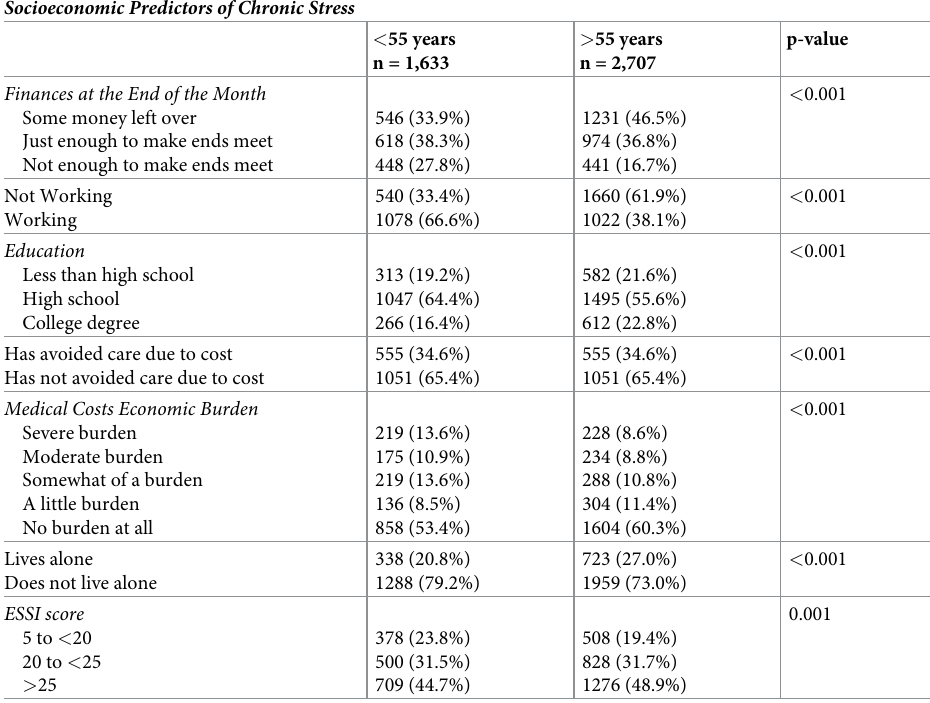
Table 3. Socioeconomic predictors of chronic stress in patients stratified by age, in TRIUMPH study. Socioeconomic Predictors of Chronic Stress